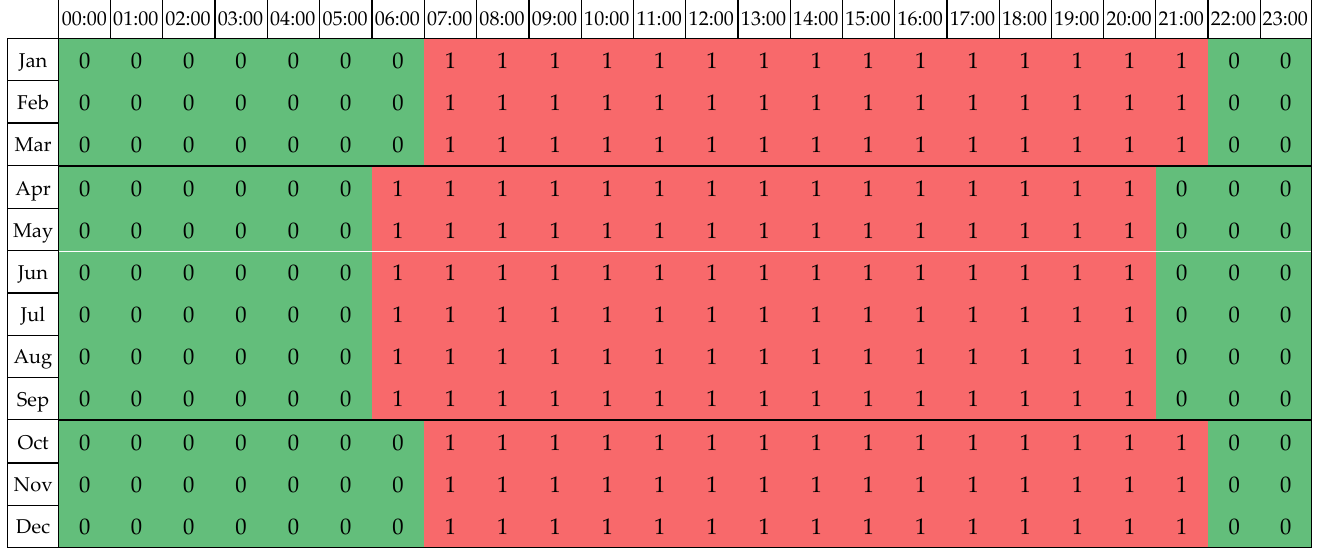
Table 2. Schedule of hours in UTC+1, time of charging the capacity fee valid from 2021; red back- ground on 1.